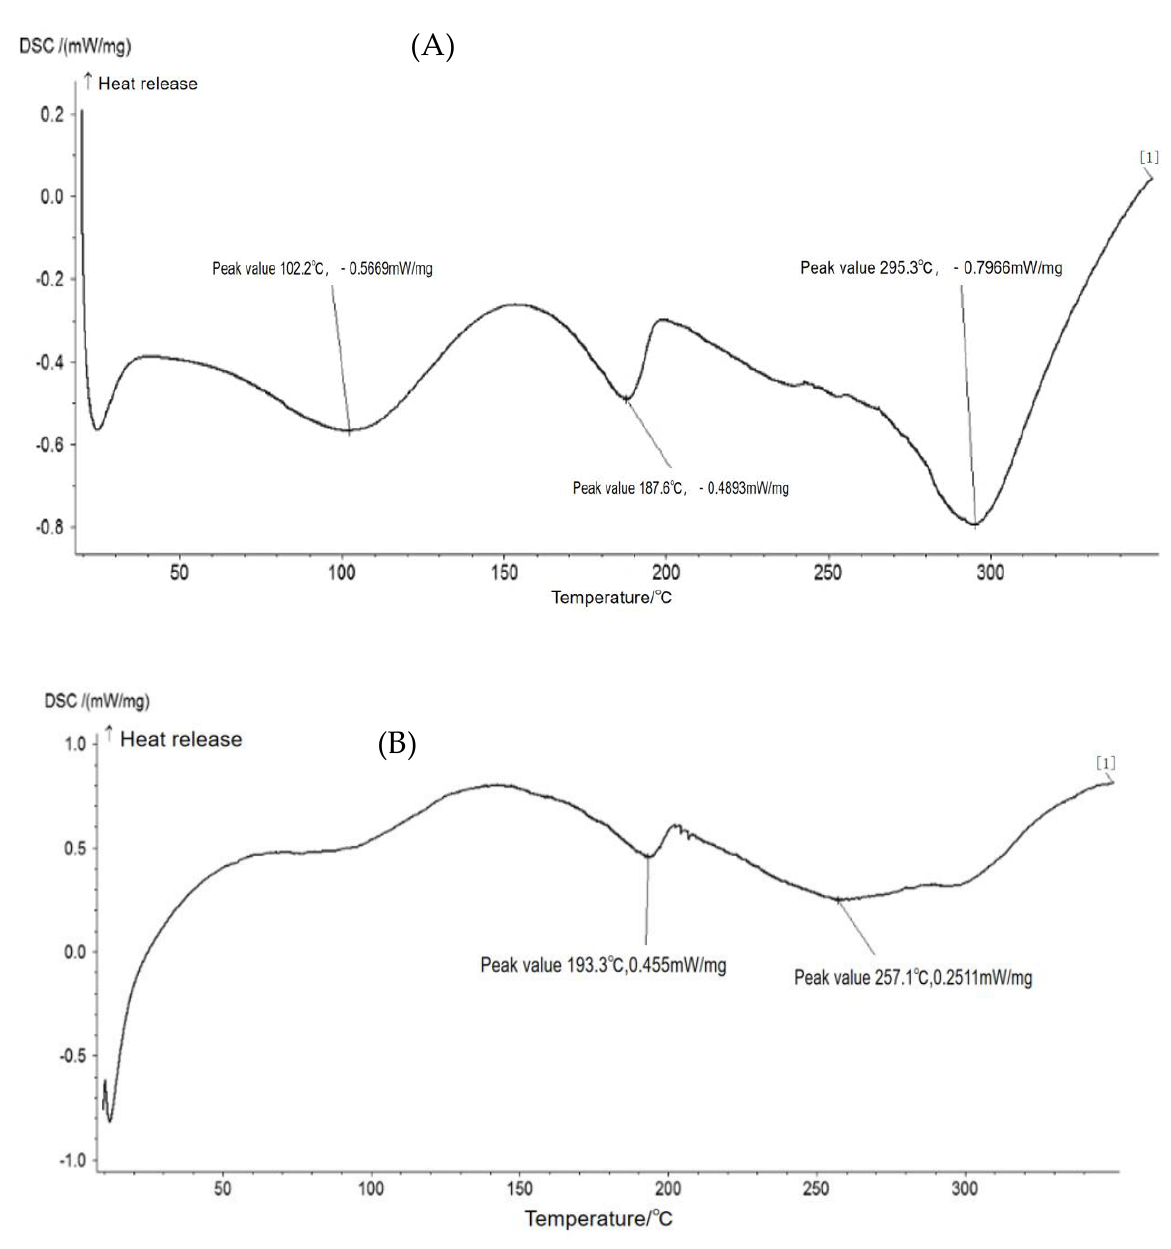
Figure 8. DSC results of soy protein/ polyvinyl alcohol composite film (( A ) without TiO 2 , ( B ) with TiO 2 ).